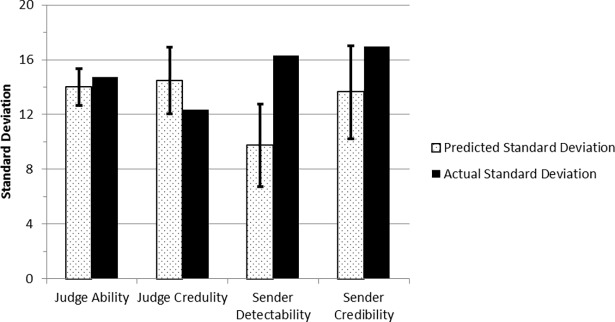
A comparison of the predicted standard deviation from Bond and DePaulo [15] with the actual standard deviation from the current experiment’s estimates of judge ability, judge credulity, sender detectability and sender credibility.Error bars represent the predicted standard deviations within a 95% Confidence Interval.